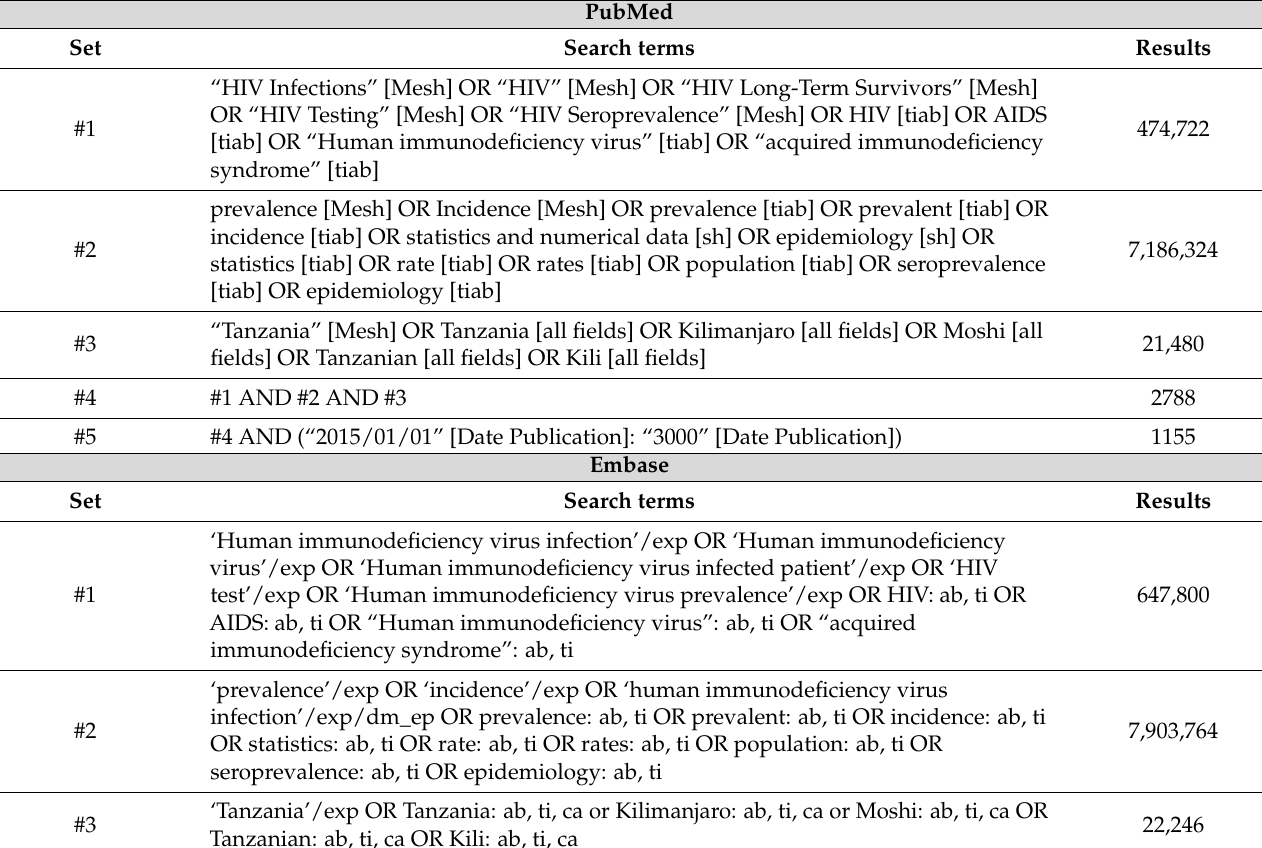
Table A1. Search strategy employed to identify studies in the systematic review. Methods are detailed in Section 2.2 of the